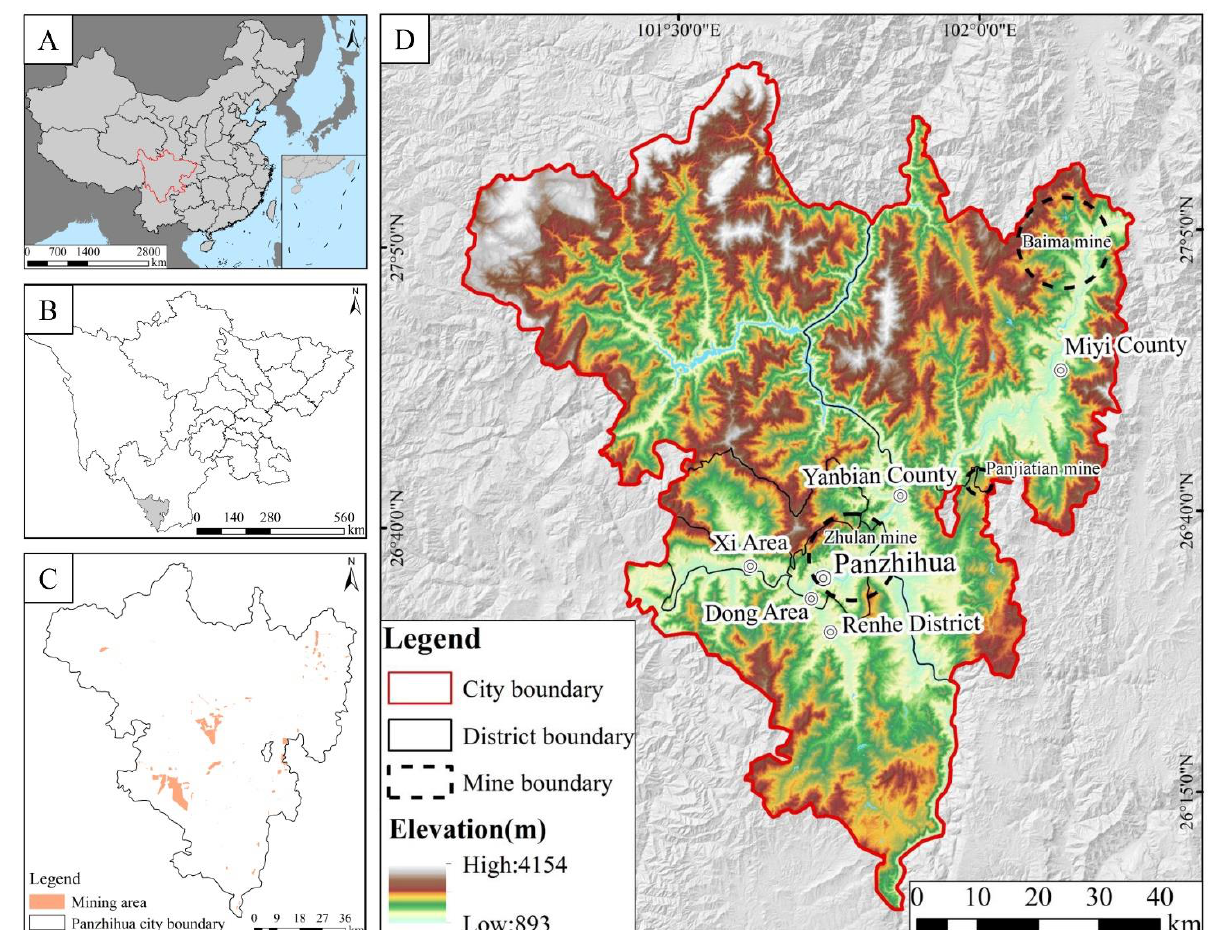
Figure 2. The Situation of the Study Area ( A ): Location of Sichuan Province, ( B ): Location of Panzhihua, ( C ): Distribution of Mining Areas in Panzhihua, ( D ): Distribution of the Three Mining Area Sites in Panzhihua City).